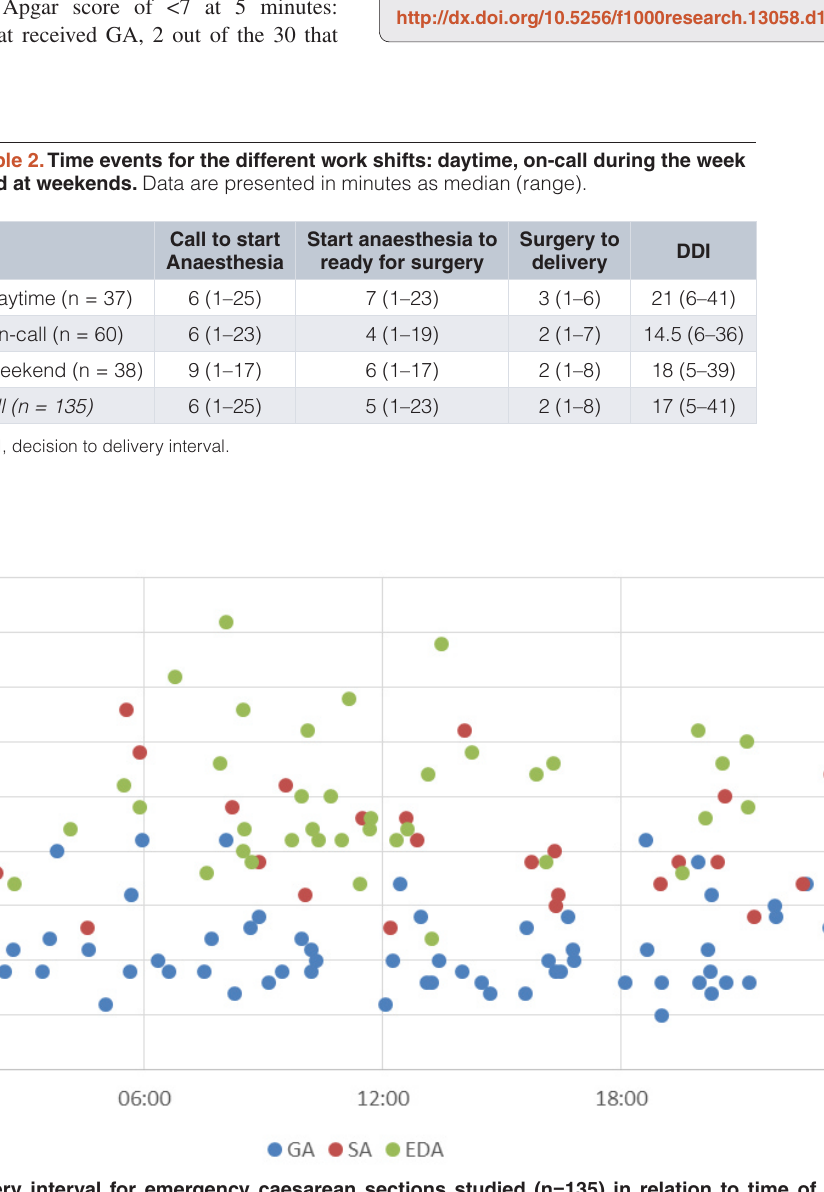
call to start of anaesthesia, start of anaesthesia to surgery, and surgery to delivery, no statistical difference between the different working shifts was